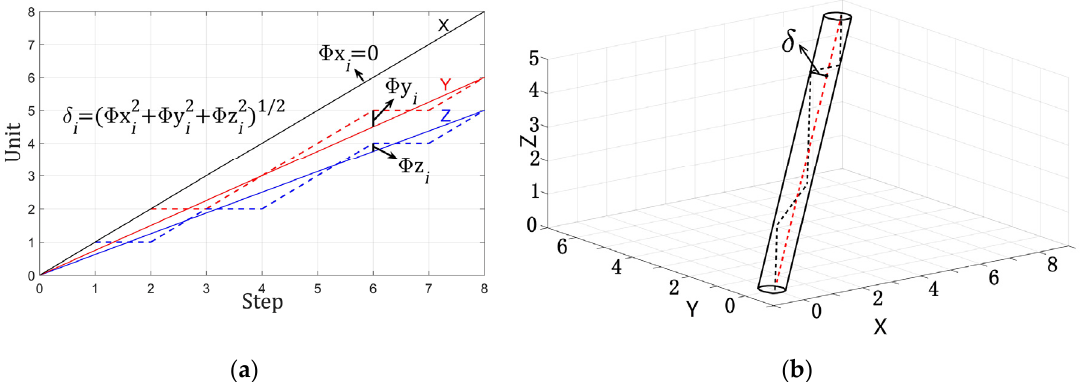
Figure 6. Results of the spatial straight-line algorithm. ( a ) The motion process of each axis. ( b ) Spatial straight line and straightness error. Note: Figure 6a shows the motion process for each axis. The ordinate is the number of units, and the abscissa is the number of forward steps. The black, red, and blue lines represent the x , y , and z -axis. The solid line is the theoretical value, while the dashed line is the actual value.